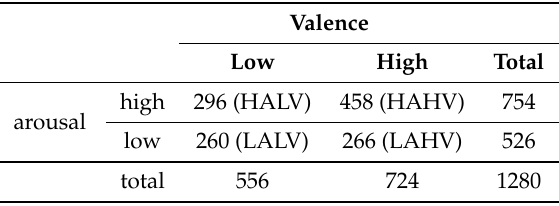
Table 1. The number of samples classified using binary or four classes. (H: high, L: low, V: valence, A: arousal, e.g., HAHV: high arousal, high